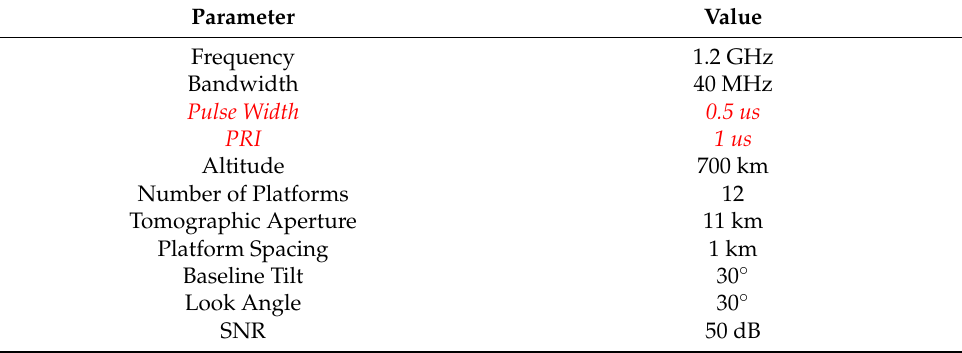
Table 7. Parameters used for Example